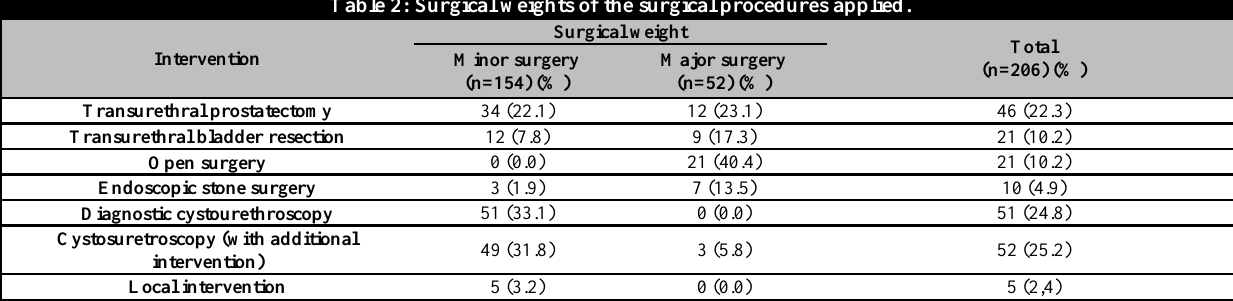
Table 2: Surgical weights of the surgical procedures applied. Surgical